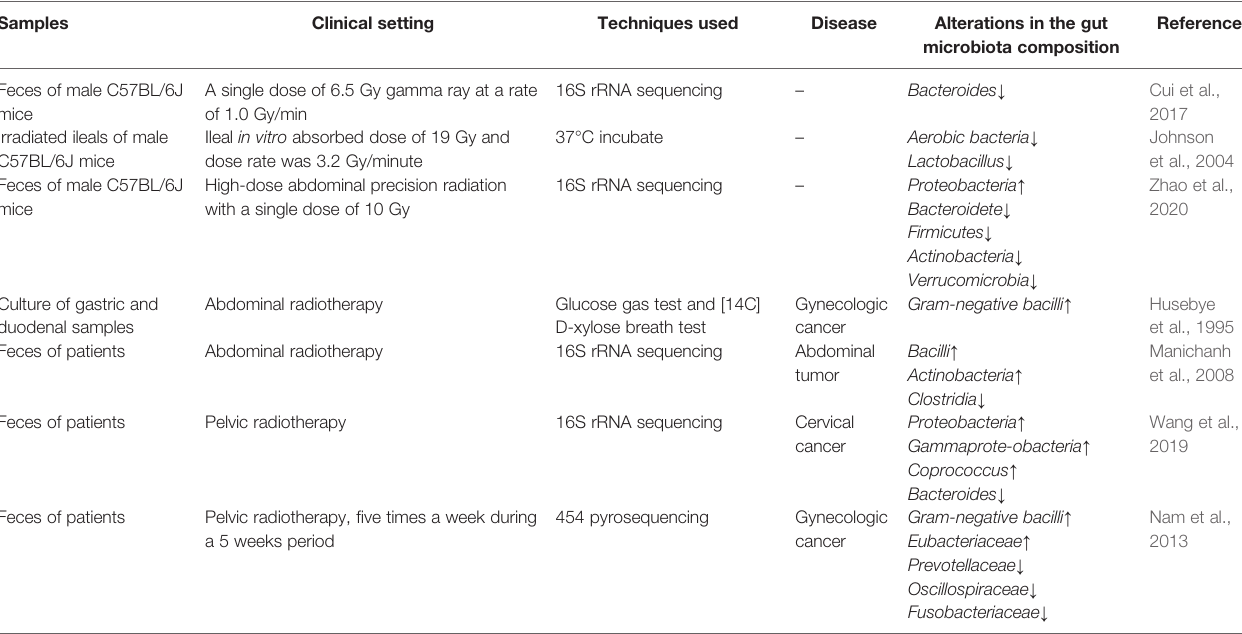
TABLE 1 | Radiotherapy affects the composition and diversity of intestinal